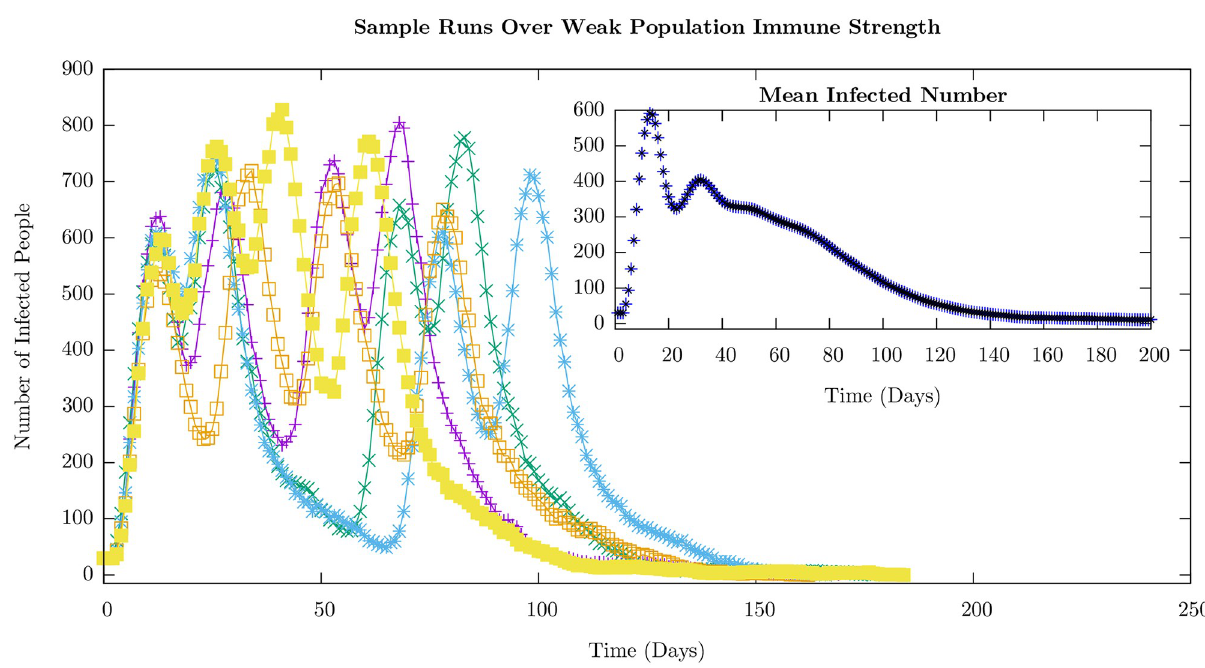
Fig 3. ABM results for the infected (the sum of exposed and infectious) agent number time series, with I i 2 [0, 4], for a population with weak immune strength corresponding to no immunization prior to the onset of the infection. Individual sample runs are shown along with the mean infected number, averaged over 10,000 runs, in the inset. This level of immunity leads to time scales for the rate of infection transmission between individuals comparable to or faster to the time duration before which an infectious individual recovers. However, the inter-cohort spread, through the weak, intermediate connections, is slow and the position of the peaks in the succeeding cohorts successively connected varies from run to run. The statistics of where the first peak occurs and the time interval between the first and second peaks are shown in Figs 5(a) and 7. The other parameters used in the simulation given in Table